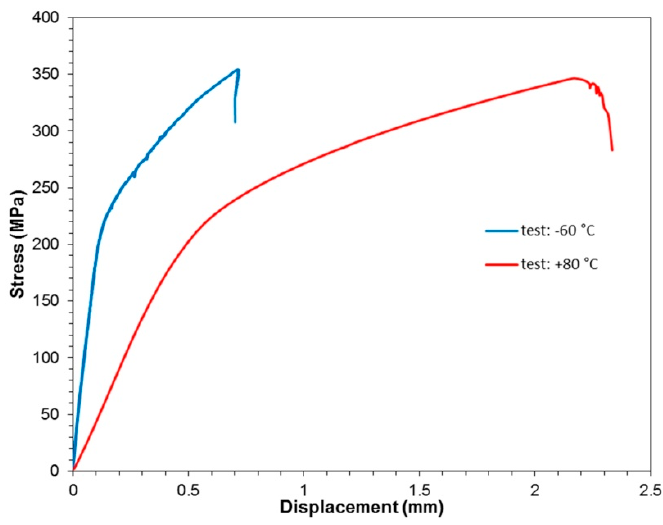
Figure 11. Tensile curves from the static tests at various temperatures.